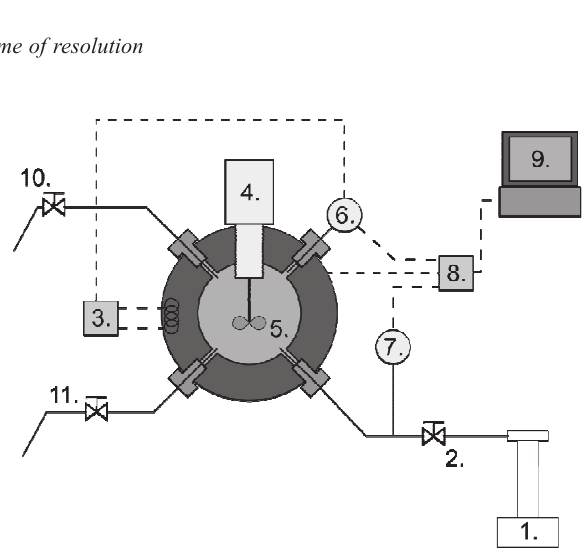
Fig. 1 Variable volume high pressure view cell: 1. ISCO 260D syringe pump; 2. Regulating